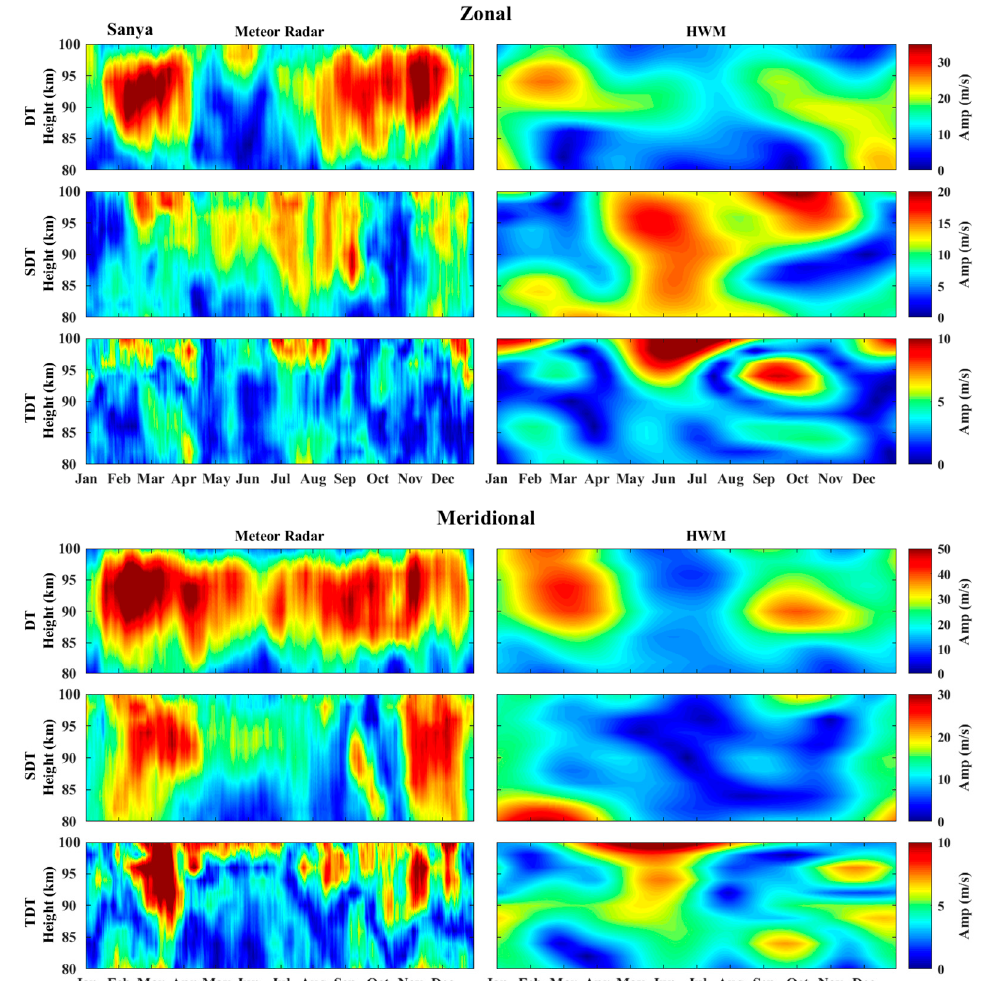
Figure 7. Diurnal (DT), semidiurnal (SDT), and terdiurnal (TDT) tidal amplitude obtained from Sanya meteor radar measurements ( left column ) and HWM14 ( right column ).